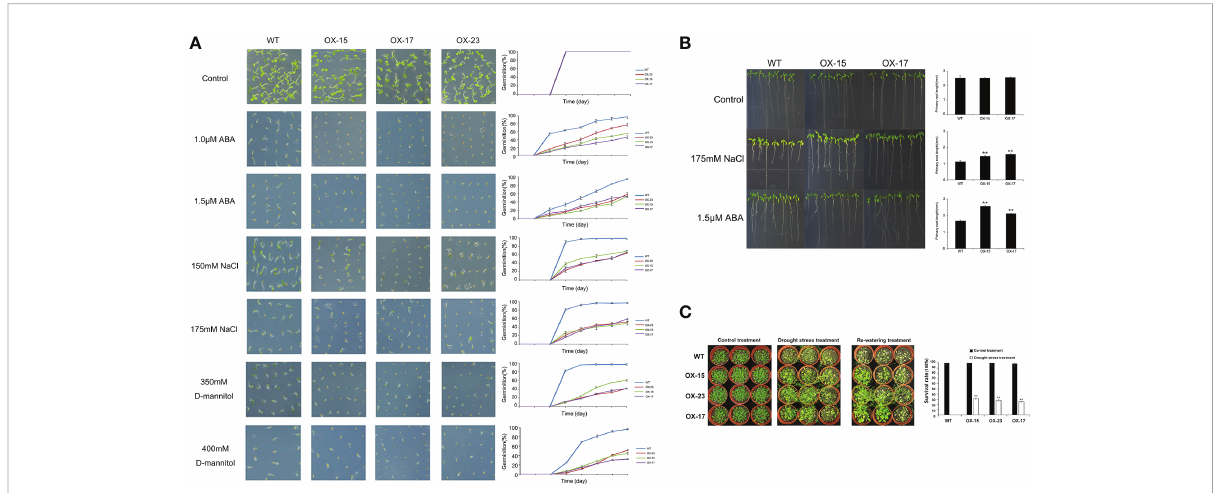
FIGURE 6 Germination and phenotype analysis ZmNAC19 overexpressing Arabidopsis. (A) Germination assays of ZmNAC19 were performed under the presence of 1.0 m M and 1.5 m M ABA, 150 mM and 175 mM NaCl, 350 mM and 400 mM D-mannitol. Each measurement consists of 50 seeds. Data are means ±SD of three biological replicates for 8 days. (B) Root length of the ZmNAC19 overexpressed transgenic lines in the presence of 1.5 m M ABA and 175 mM NaCl. (C) Performance and survival rate of the ZmNAC19 overexpressing lines under drought stress and re-watering treatments. Three biological replicates and calculate the average. Highly signi fi cant differences (P < 0.01) were represented by **.